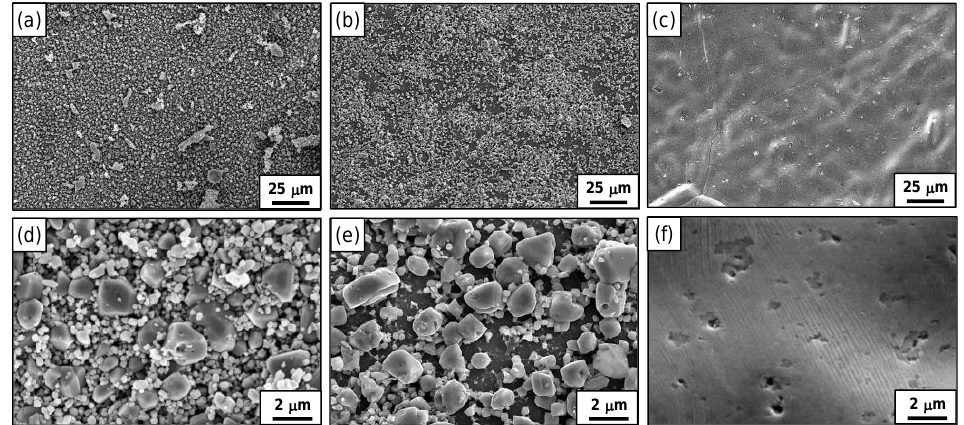
Figure 8. SEM micrographs of the PCHE flow channel surfaces: ( a , d ) before chemical cleaning; ( b , e ) after the first step cleaning for 12 h; ( c , f ) after the second step cleaning for 12 h.